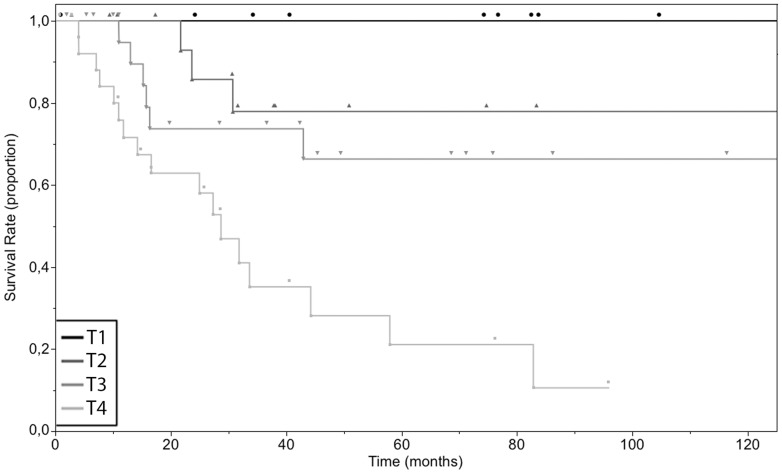
Overall 10-year survival of the 79 cases of primary mucosal melanoma classified as T1 (n = 10), T2 (n = 18), T3 (n = 24), T4 (n = 27), according to the tumor thickness of the primary at diagnosis.Tumors classified according to the AICC, 7th edition (2009).